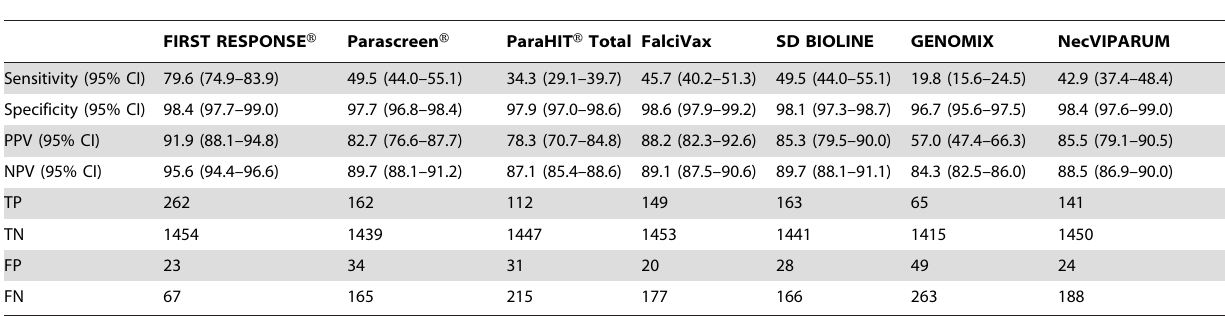
Table 2. Evaluation of P. vivax by seven different RDTs against light microscopy as gold standard in four district of Madhya Pradesh, central